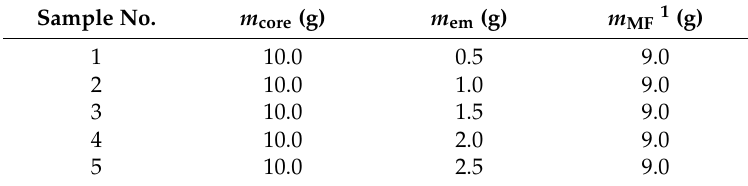
Table 4. Components of M-NEPCMs prepared with different amounts of emulsifier.